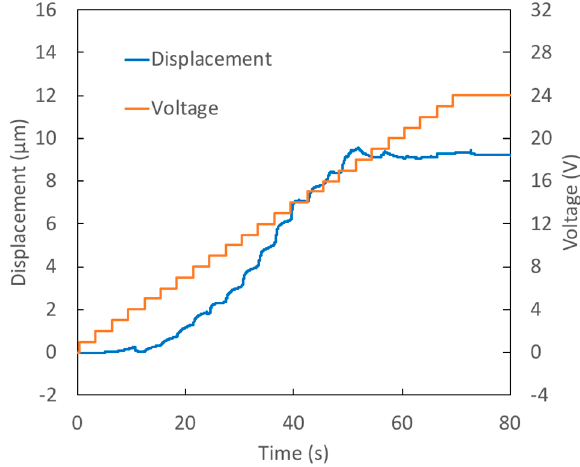
Figure 4. Test 2–Response of prototype with a thin (39 µ m), small diameter (439 µ m) membrane to staircase voltage signal.